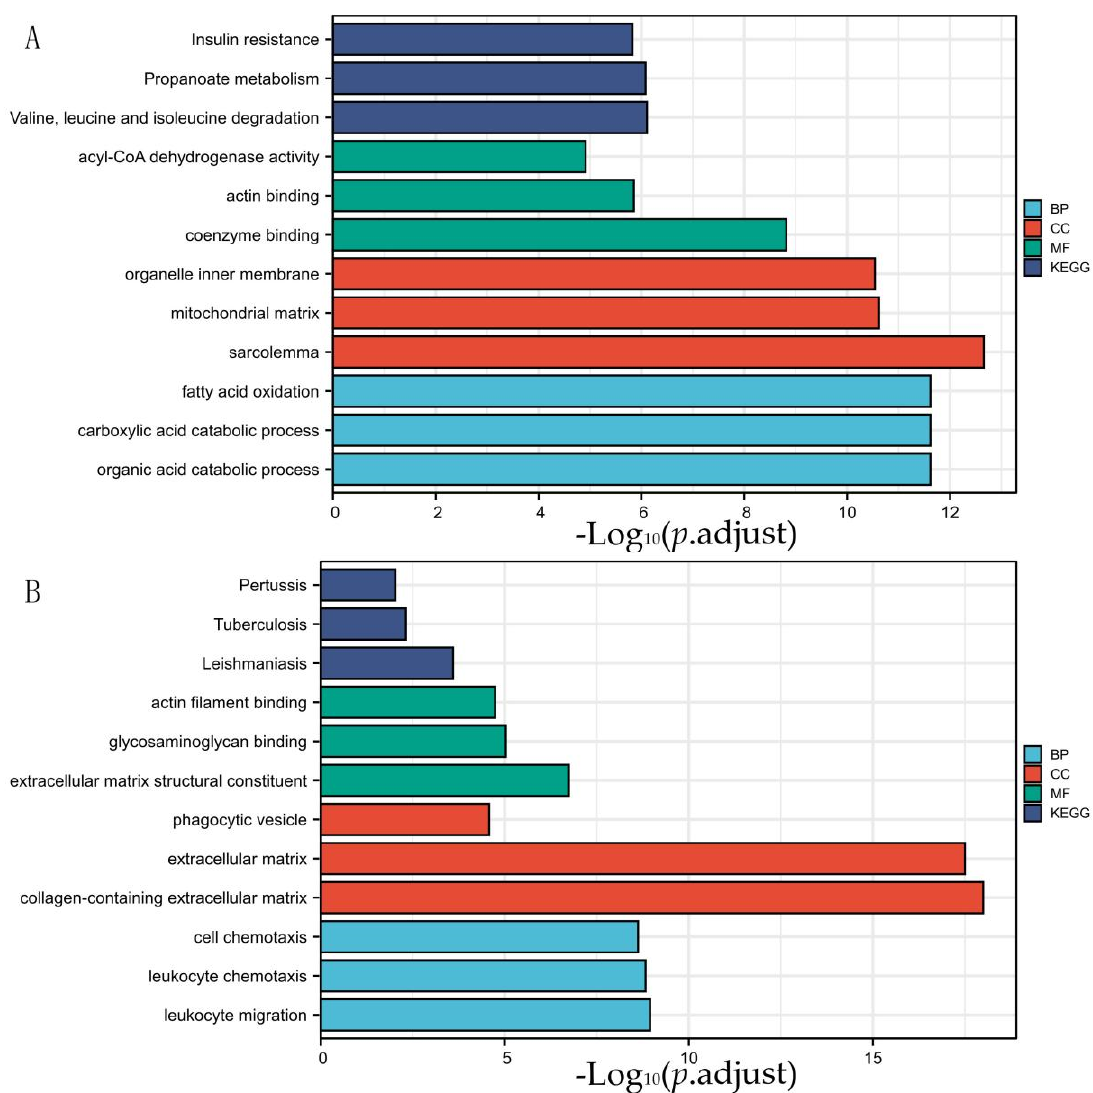
Figure 4. GO and pathway analysis of DEGs in PO group. ( A ) is the figure of up-regulated differential gene, and ( B ) is the figure of down-regulated differential gene. DEGs were divided into KEGG pathway and 3 functional groups, including BP, CC, and MF. KEGG: Kyoto Encyclopedia of Genes and Genomes; GO: Gene Ontology; BP: biological process; CC: cellular component; MF: molecular function; DEGs: differentially expressed genes.